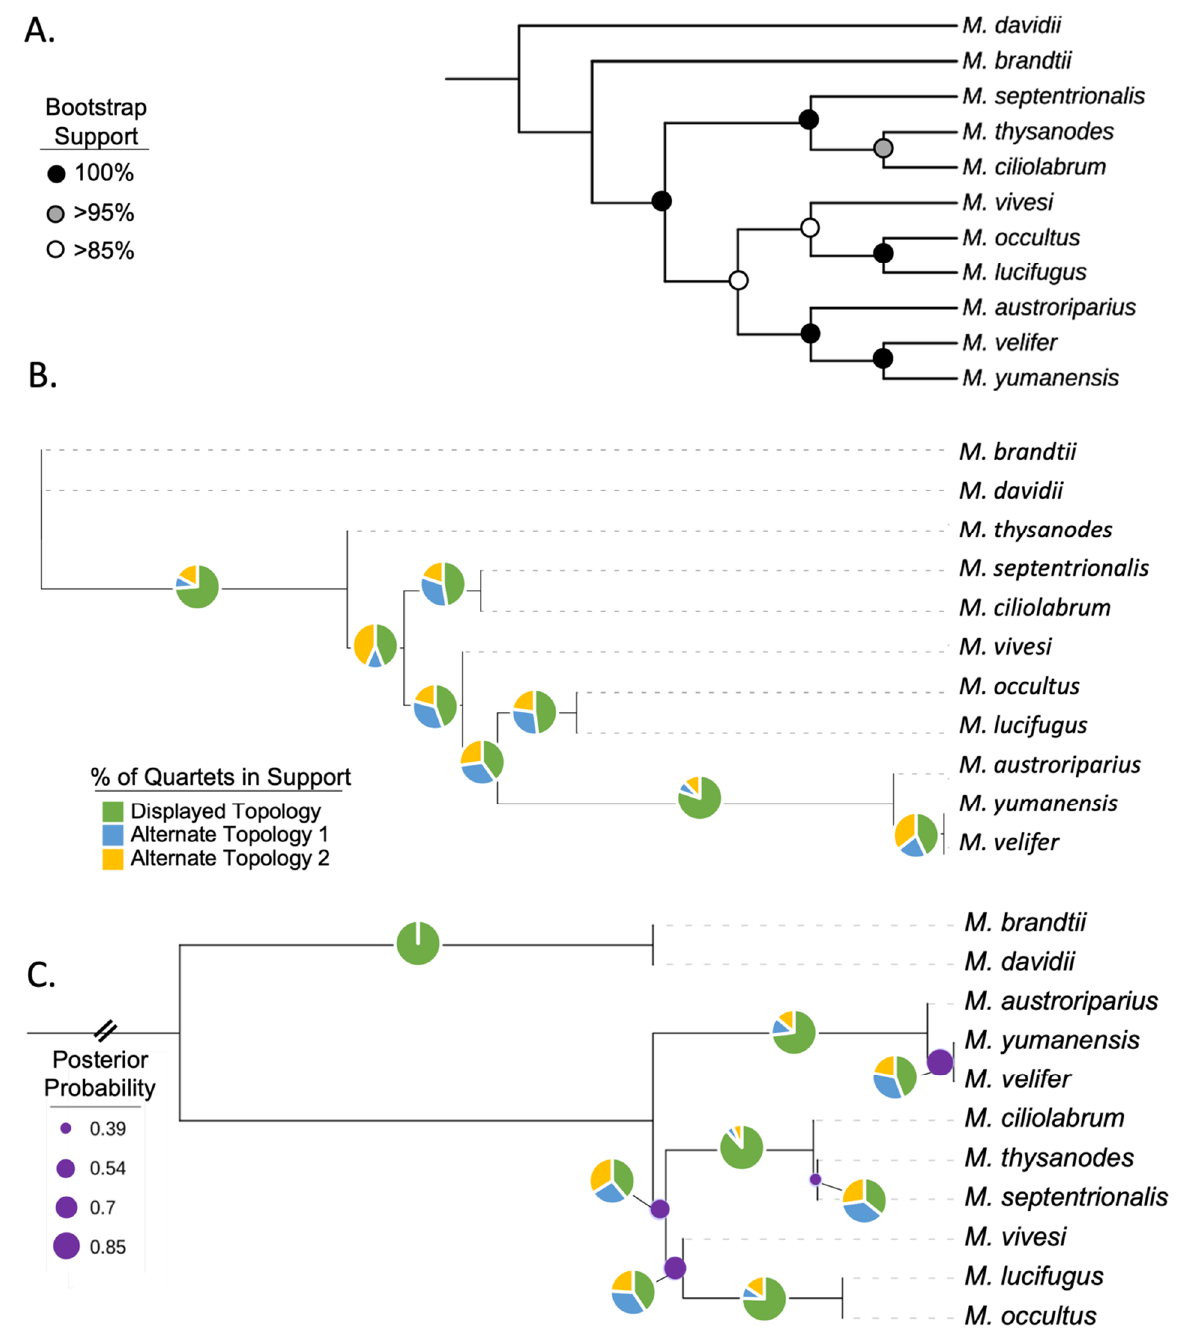
Figure 2. ( A ) Majority rule Dollo parsimony consensus tree constructed from 10,595 orthologous Ves insertions with 1000 bootstrap replicates. Circles on nodes represent bootstrap support values (black = 100%, grey > 95%, white > 85%). ( B ) Ves phylogeny inferred by ASTRAL using incompletely resolved bipartitions as gene-trees. All branches had posterior probability of 1. In Figures ( B ) and ( C ), pie charts on each branch show the % of quartets supporting the three topologies at that branch. ( C ) UCE phylogeny inferred by ASTRAL using gene trees of 2797 UCE loci. Purple dots on branches indicate p -values > 0.05 from polytomy testing (suggesting a polytomy would better represent this node) and are scaled by size according to posterior probability. The basal branch was truncated for better